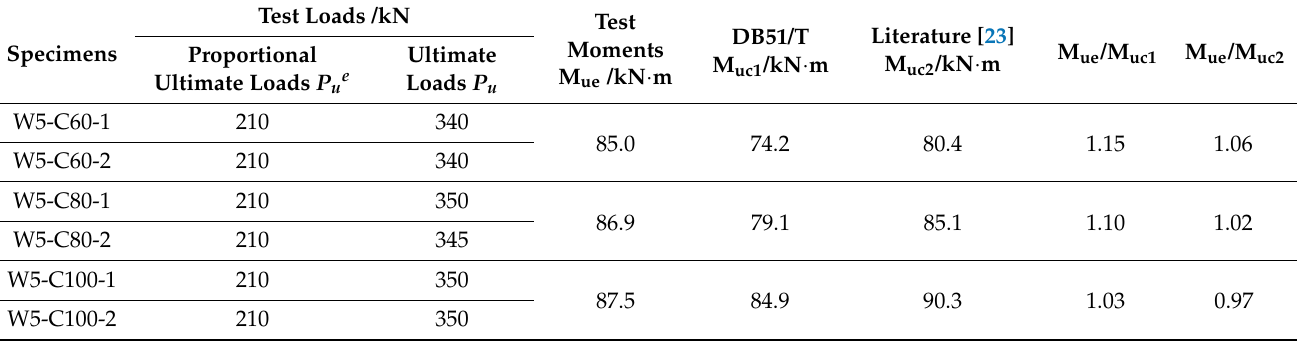
Table 6. Test results of the